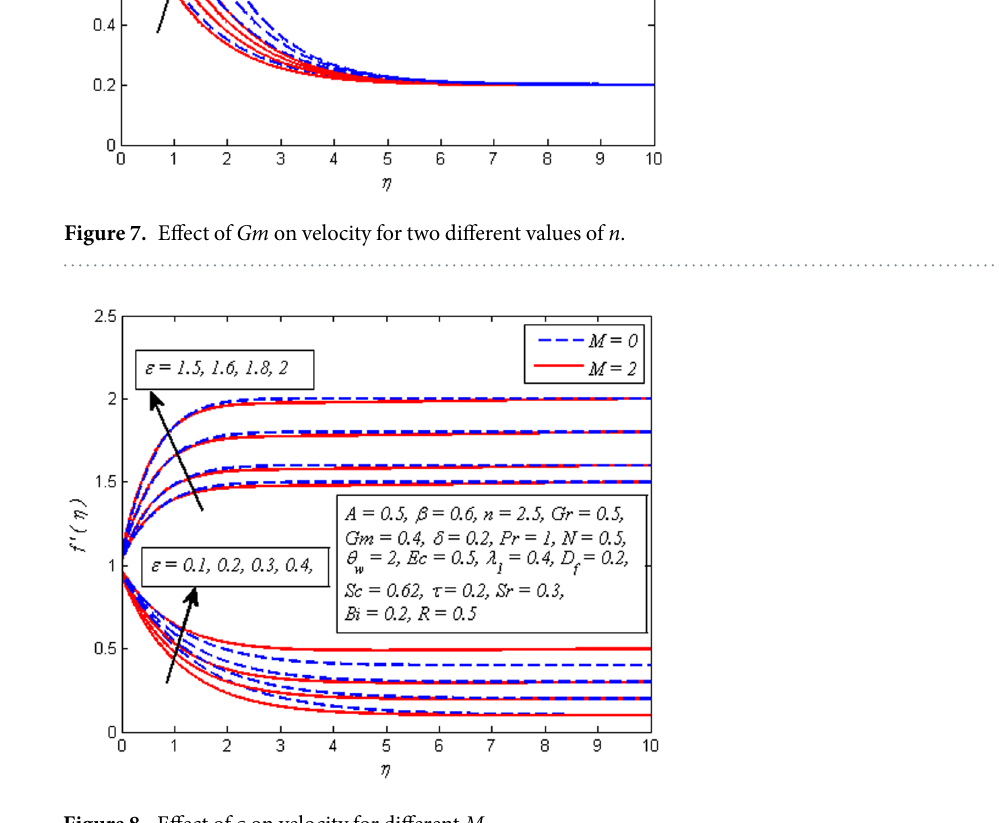
Figure 8. Effect of ε on velocity for different M